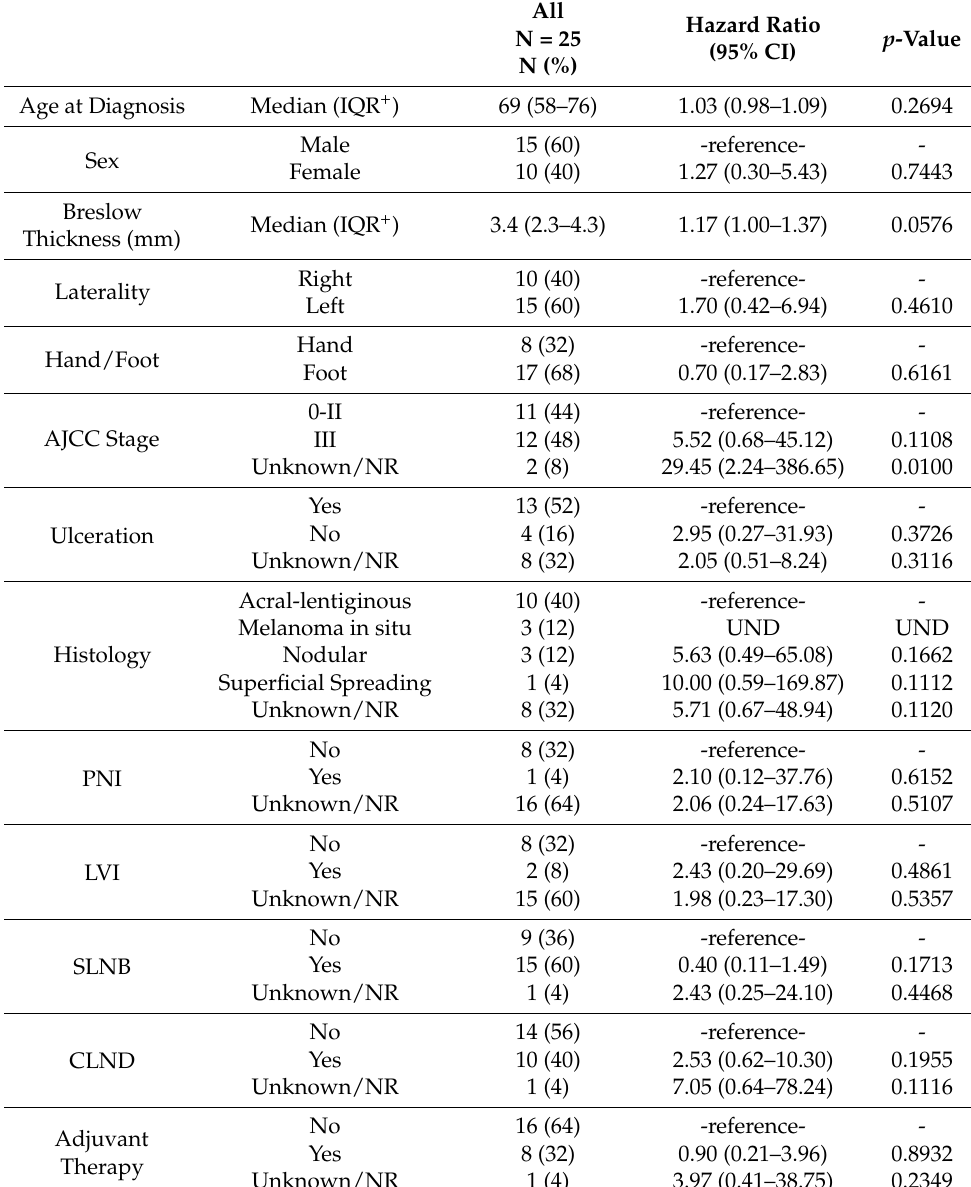
Table 3. Univariate Cox Proportional Hazards on Overall